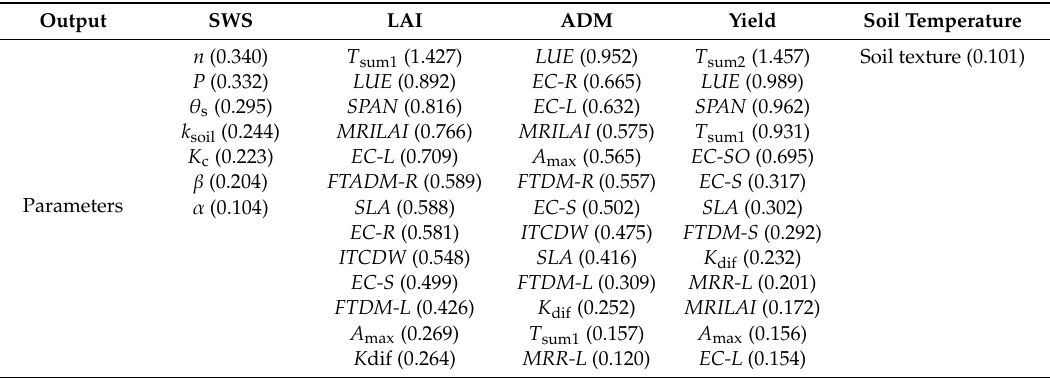
MRR-L (0.120) EC-L (0.154)